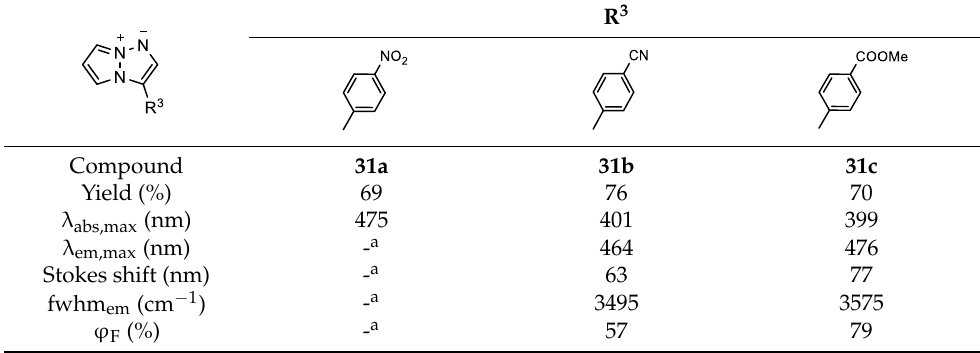
Table 7. Fluorescent properties and reaction yields of 3-substituted TAPs 31 in DCM.